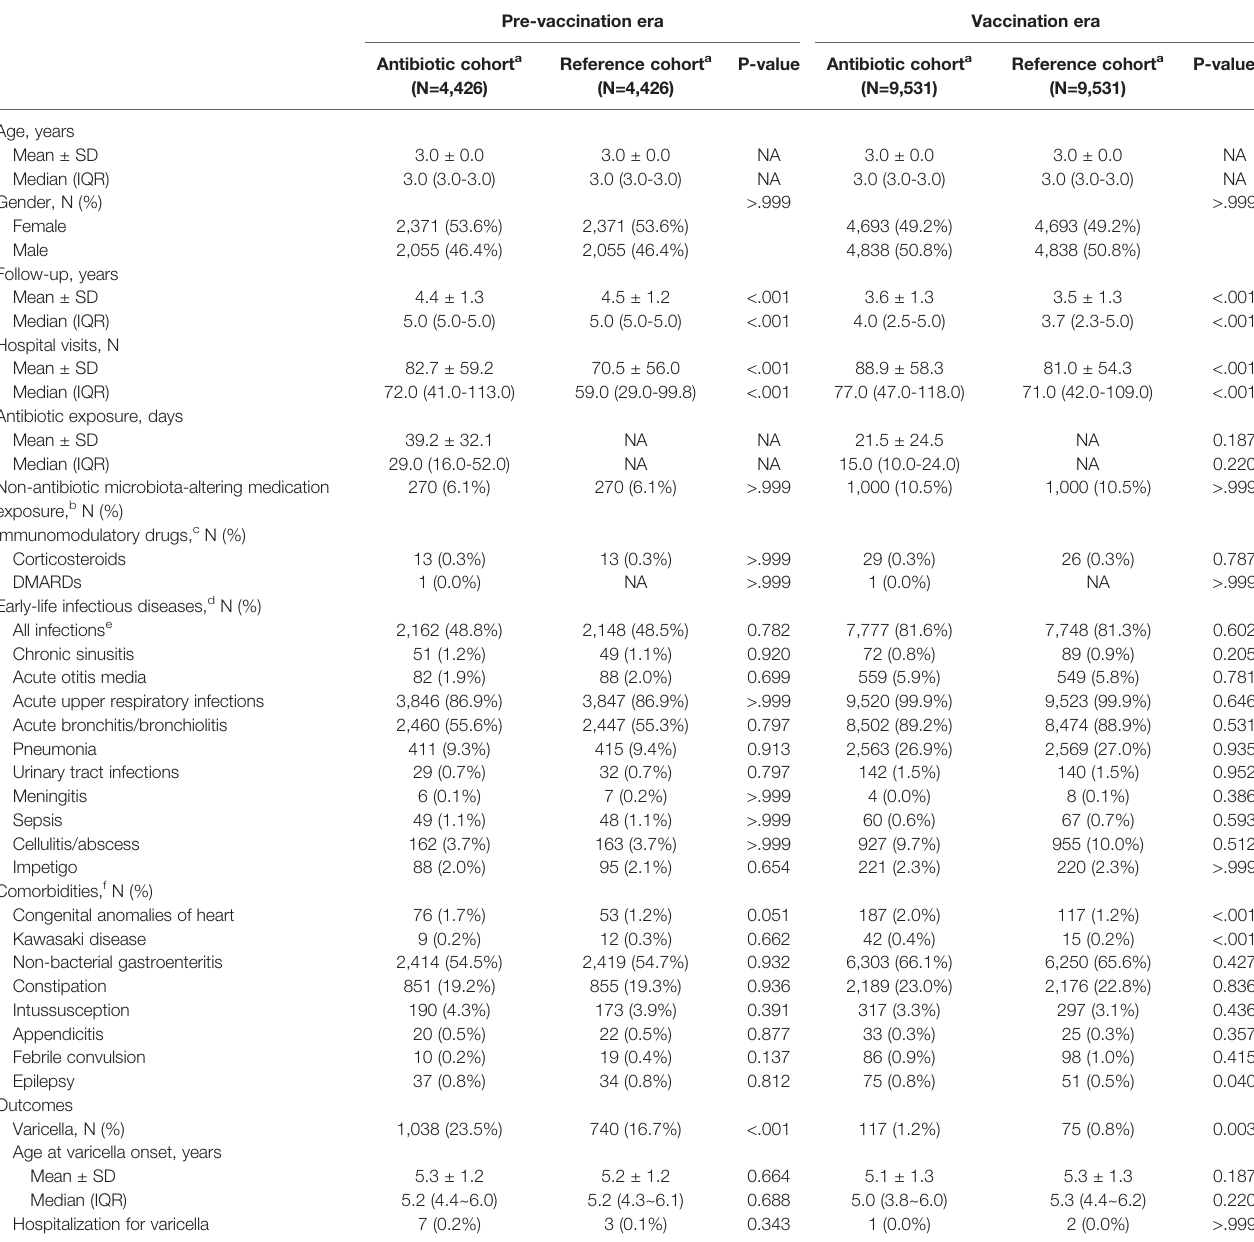
TABLE 1 | Demographic characteristics and outcomes of matched study subjects in antibiotic and reference cohorts in the pre-vaccination and vaccination eras. Pre-vaccination